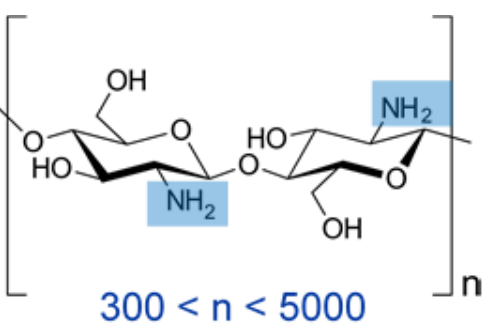
Figure 2. Spatial structure of the chitosan